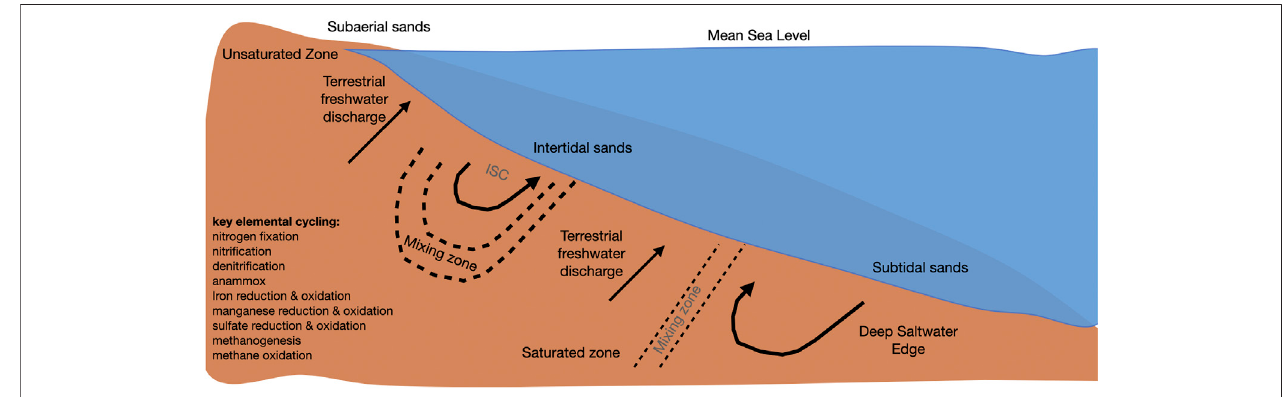
FIGURE 1 | Diagram of a beach aquifer. Adapted from Robinson et al., 2018 and Ruiz-González et al., 2021 (ISC: intertidal saltwater cell).